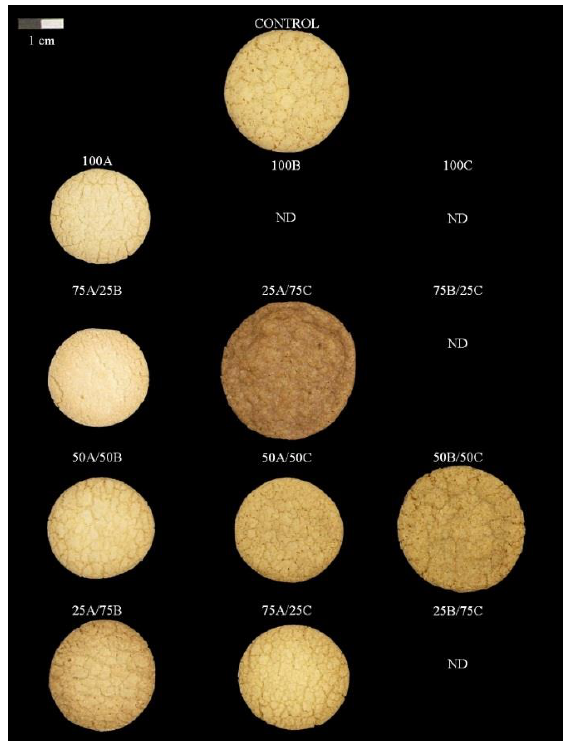
ND: no development. Data are expressed as means ± SD of duplicate assays. The values with the same letter in the same column do not present significant differences ( at a significance level of p < 0.05).